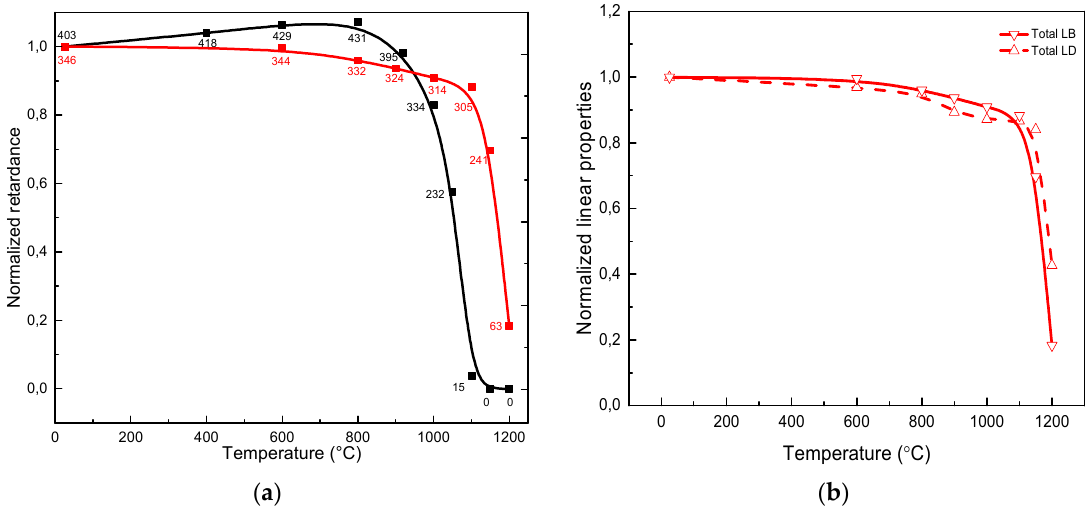
Figure 5. ( a ) Experimental values of the normalized evolution of optical retardance R (proportional to LB ) at 550 nm with annealing temperature. Note we add the retardance values for each point as a label. Black dots are for the stress-engineered waveplate whereas red squares are for a nanogratings-based waveplate written in Xy configuration. ( b ) Normalized evolutions of Total LB and Total LD according to annealing temperature. Lines are guides to the eye.